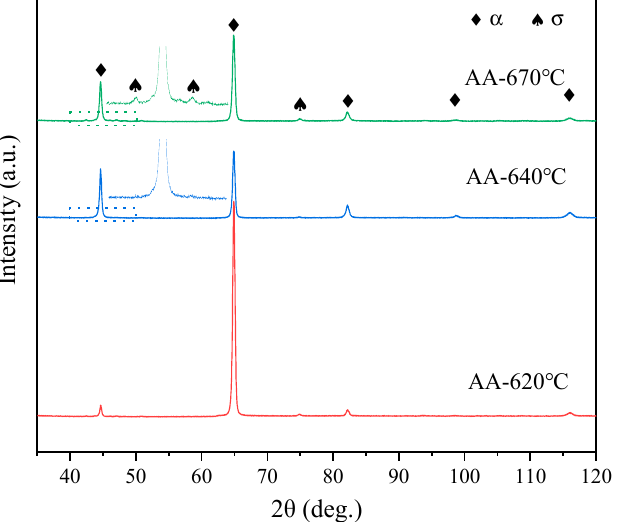
Figure 6. Diffraction patterns for in situ Fe-25Cr-15Co as-built samples treated in AA process.